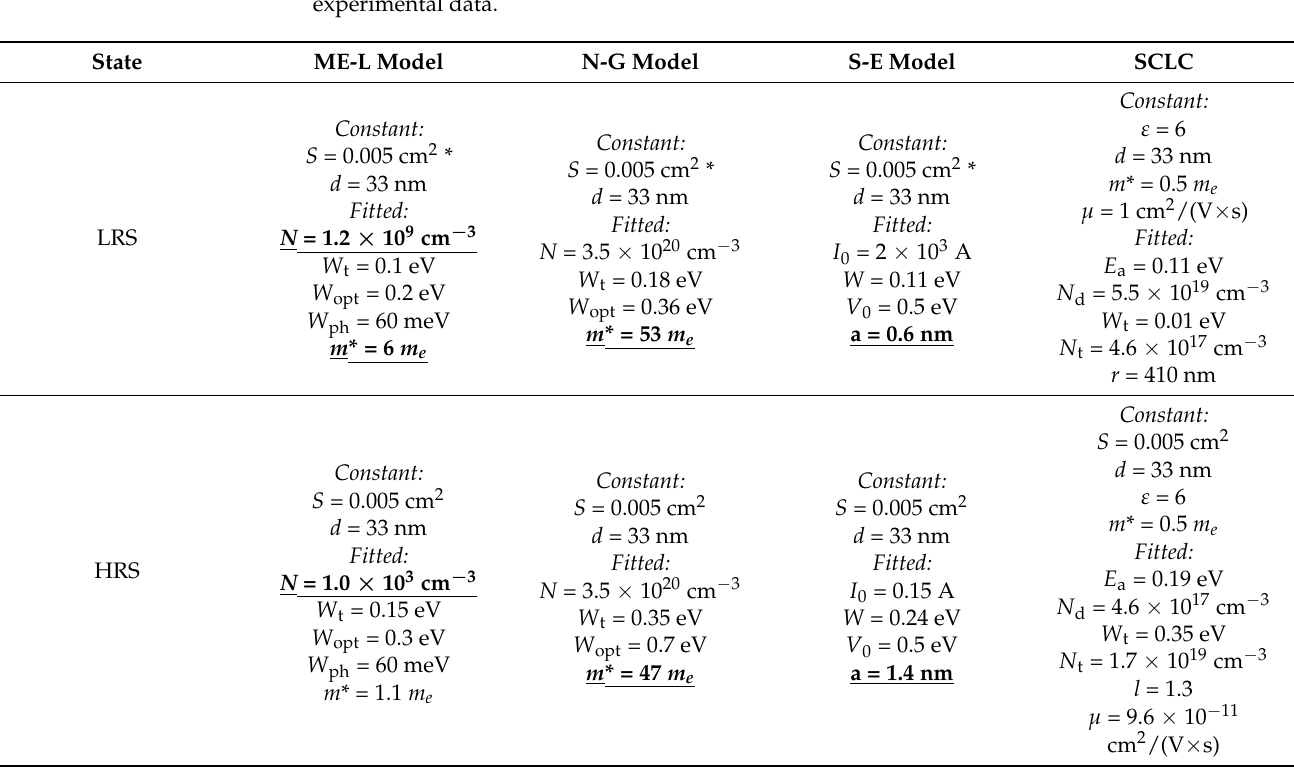
Table A2. Constant and fitted parameters of the ME-L model, N-G model, S-E model, and SCLC model. The bold and underline parameters are parameters due to which the model does not fit experimental